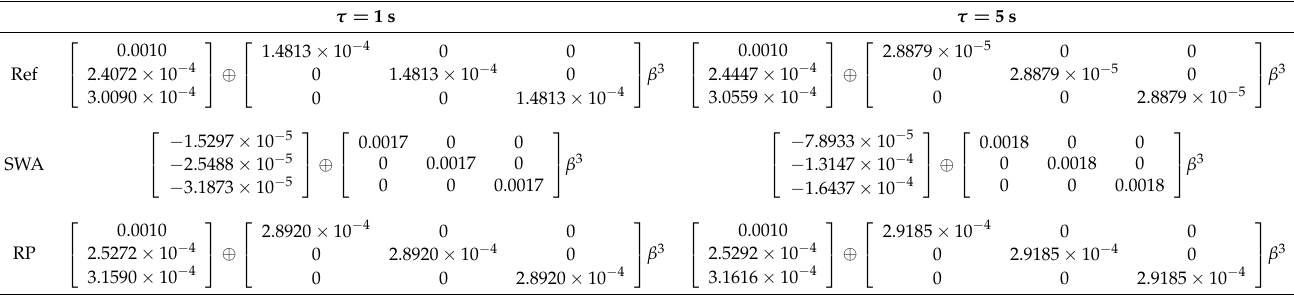
Table 2. Calculated sets for different sample times in pH